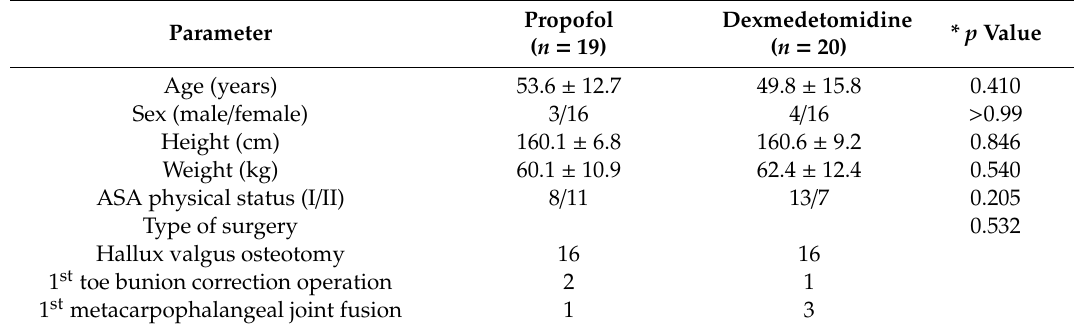
Table 1. Patient characteristics in the propofol group and in the dexmedetomidine group.